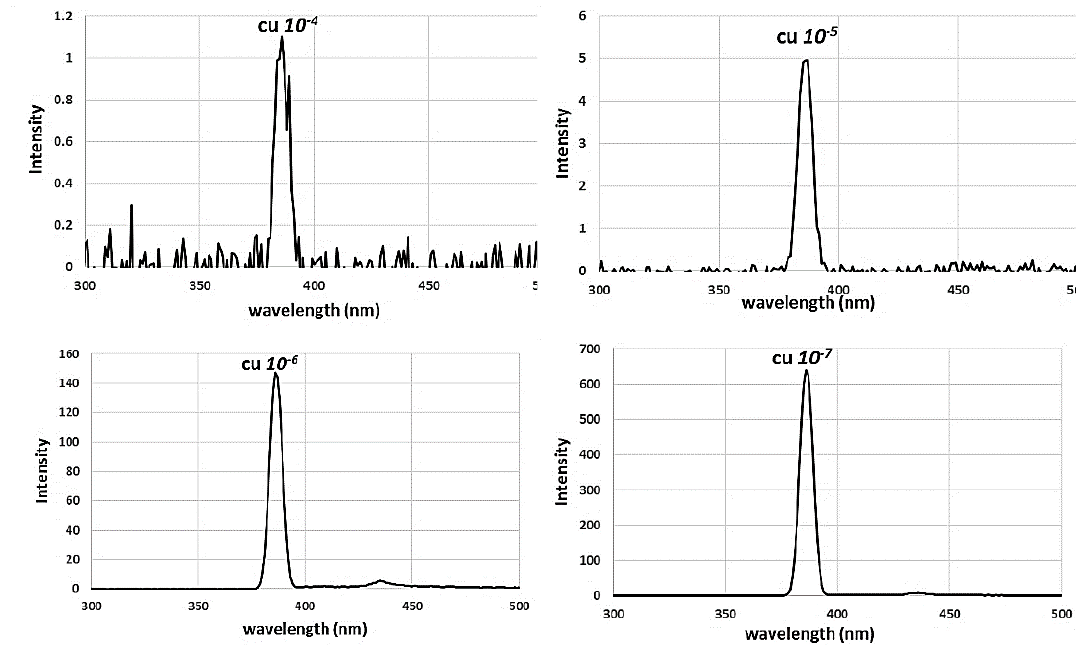
Fig.4: Fluorescence spectrum of Copper chloride with concentrations of (10 -4 , 10 -5 , 10 -6 , 10 -7 ) gm/m 3